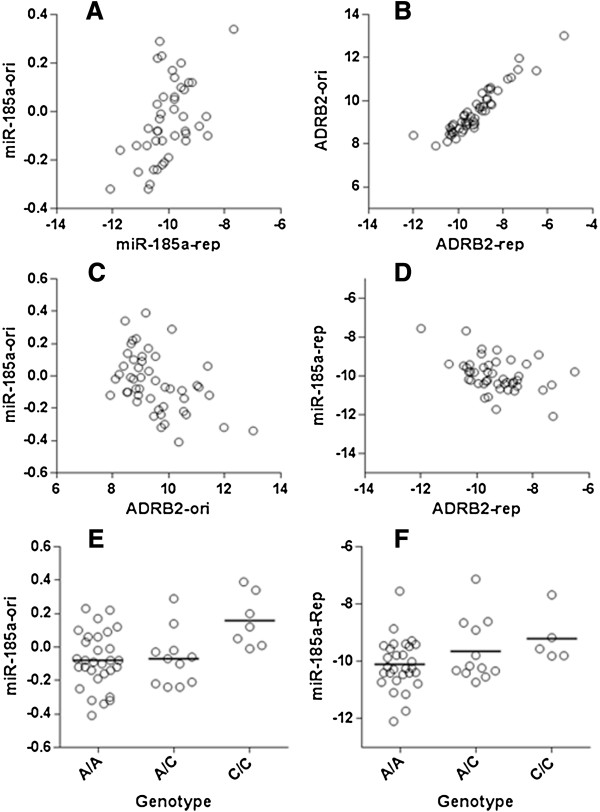
Comparison of the miRNA expression (panel A), mRNA expression (panel B), and miRNA-mRNA correlations (panels C and D) between the replication (Q-PCR, labeled as “rep”) and the original (microarray, labeled as “ori”) datasets as well as confirmation of a microarray-identified miR-eQTL (panels E and F). Data were plotted only for the samples with total RNA available (n = 53).